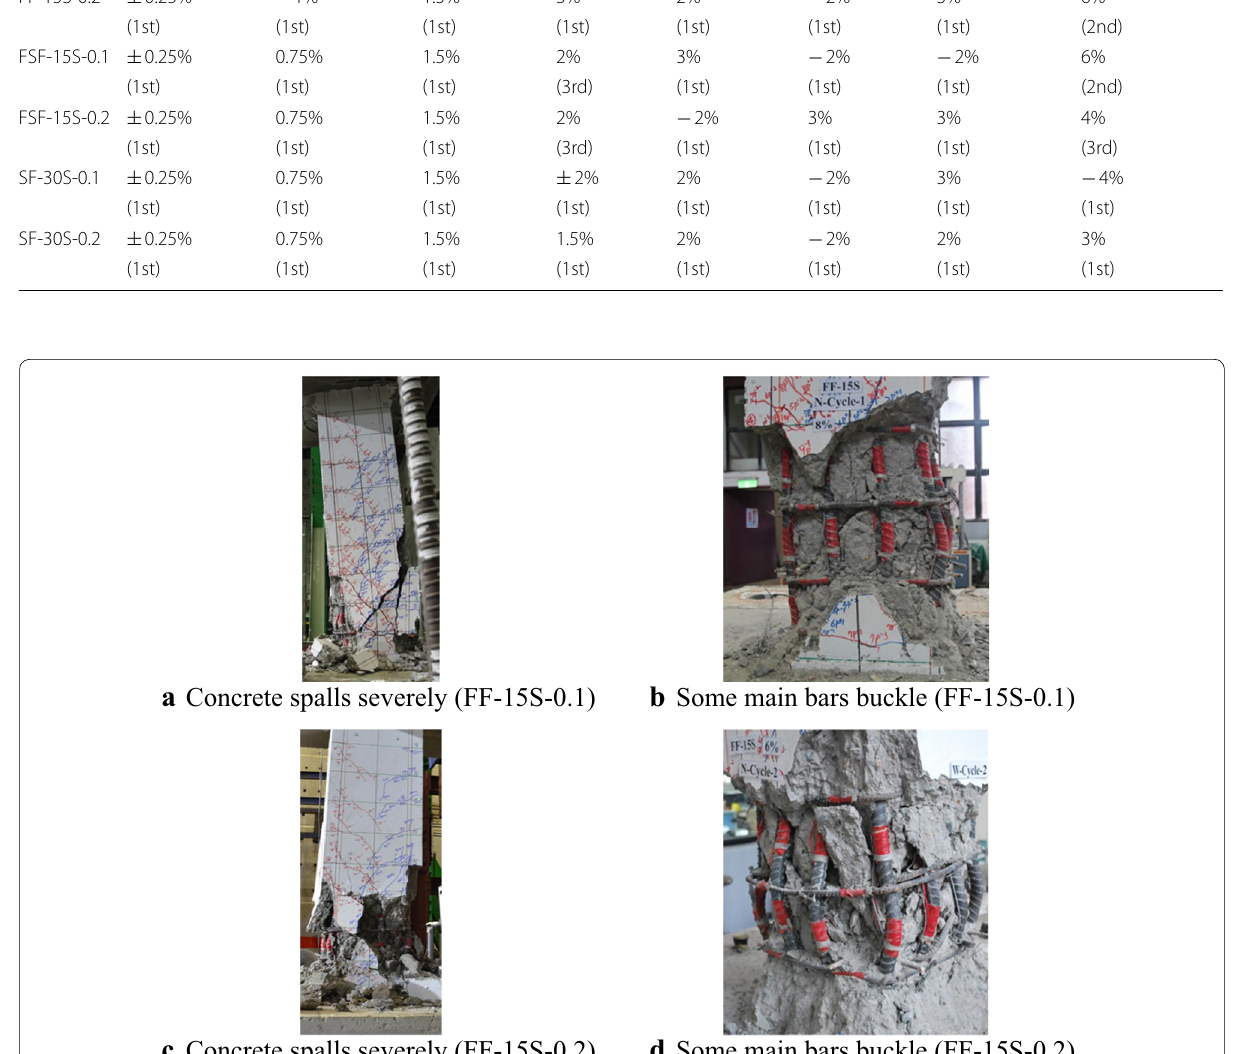
Fig. 9 Specimens of FF‑15S‑0.1 and